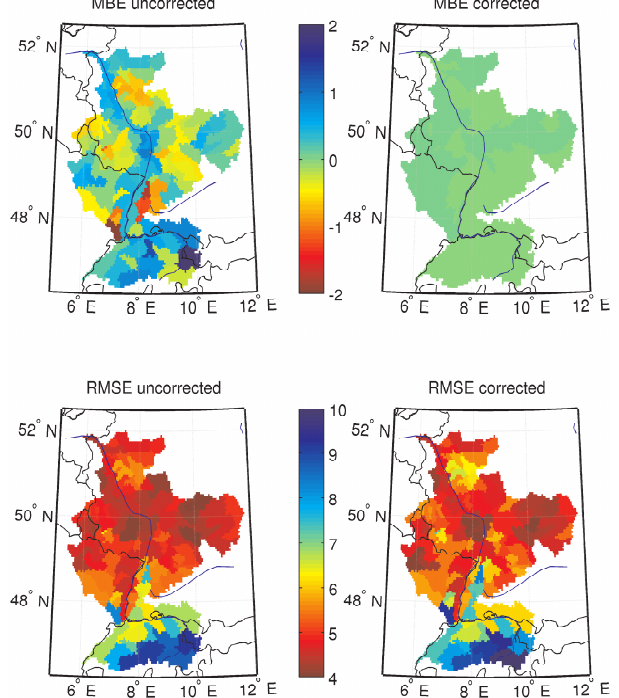
Fig. 4. Top: MBE for the uncorrected and corrected ERA15/REMO precipitation [mm] per sub-basin for the period 1979–1995; Bot- tom: RMSE for the uncorrected and corrected ERA15/REMO pre- cipitation [mm] per sub-basin for the period 1979–1995.